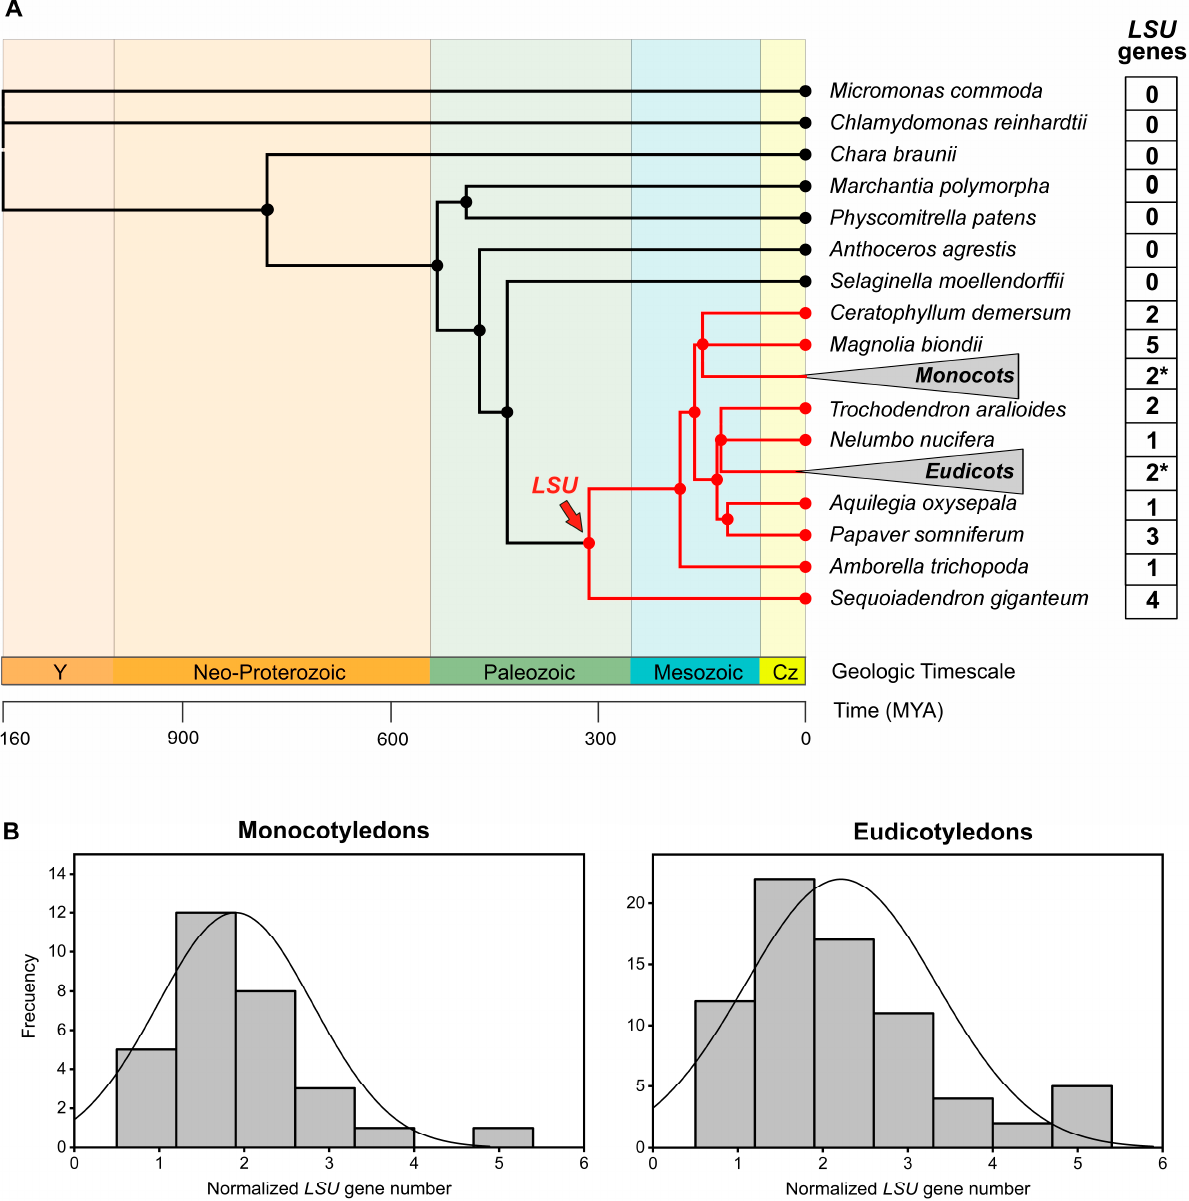
Figure 1. LSUs belong to a Spermatophyta -specific gene family. ( A ) The phylogeny of 134 plants from the PLAZA 5.0 database was used in this study. To improve visualization, 73 eudicotyledon and 31 monocotyledon species collapsed in the phylogenetic tree (triangle) and the average number of LSU genes are indicated with an asterisk. The order of tree branches and divergence time were obtained from the TimeTree database (http://timetree.org/; accessed on 13 December 2021) [36]. ( B ) The normalized number of LSU genes identified in angiosperms plants. The number of LSU genes of each species was divided by 34,075 coding genes, which is the average total number of genes in the analyzed